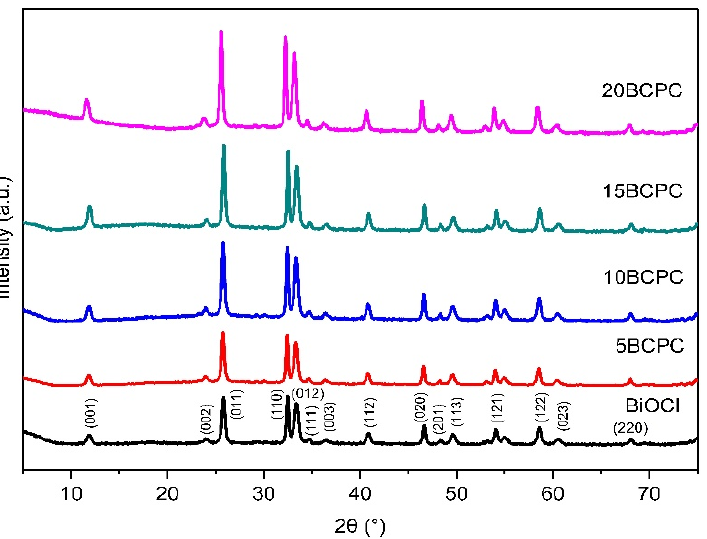
Figure 2. The XRD patterns of pure BiOCl nanoparticles and their composites with different amounts of lignin-derived biochar.